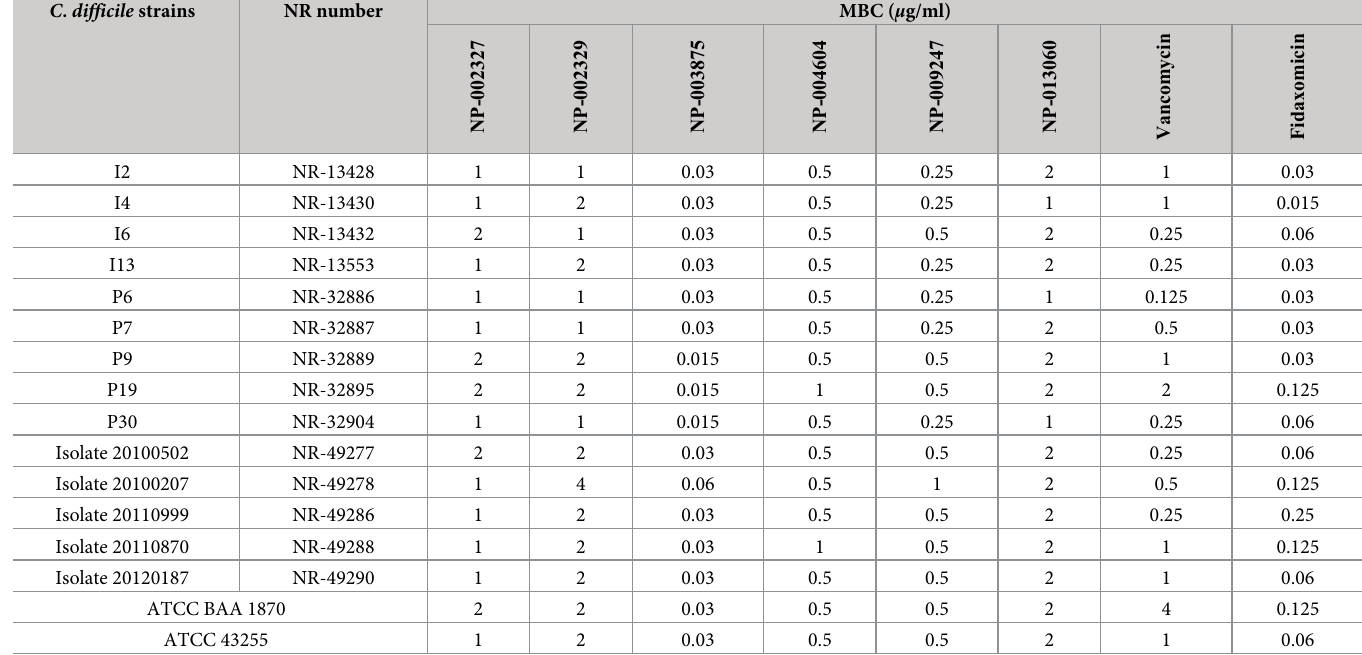
Table 2. Minimum Bactericidal Concentration (MBC) values of natural products against a panel of clinical and hypervirulent strains of C . difficile . C . difficile strains